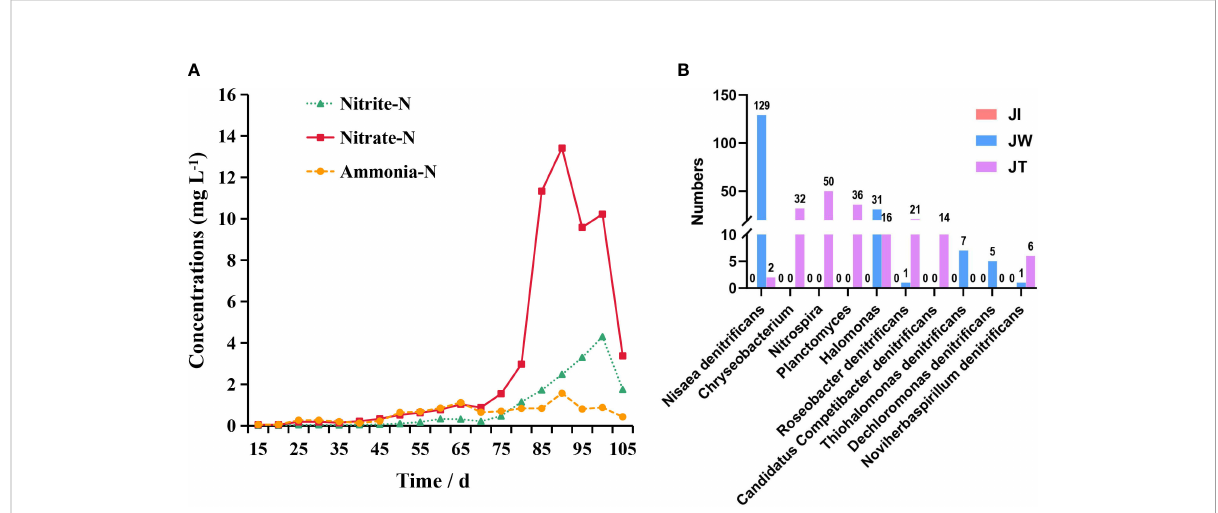
FIGURE 2 (A) Concentration of ammonia nitrogen (Ammonia-N), nitrite (Nitrite-N), and nitrate (Nitrate-N) over time in the “ Fishery-PV Integration ” ponds. (B) Bar plots show the distribution of 10 nitrogen-removing bacteria in the pond. The y-axis shows the number of genes annotated to the bacteria; the x-axis shows the name of the nitrogen-removing